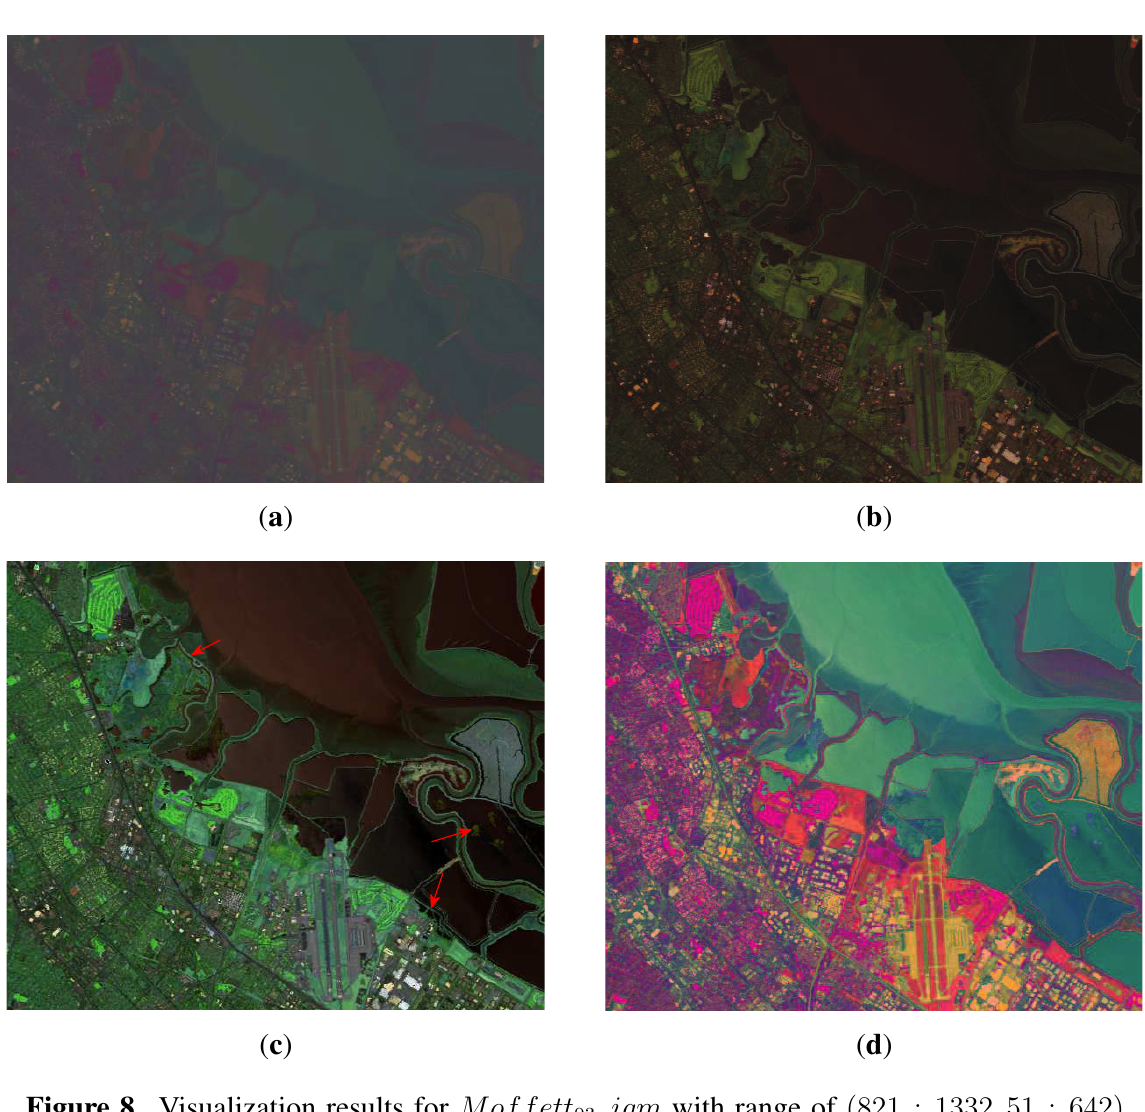
Figure 8. Visualization results for Moffett obtained by: ( a ) PCA; ( b ) BCOCDM; ( c ) PDADVS; and ( d ) PCA %2